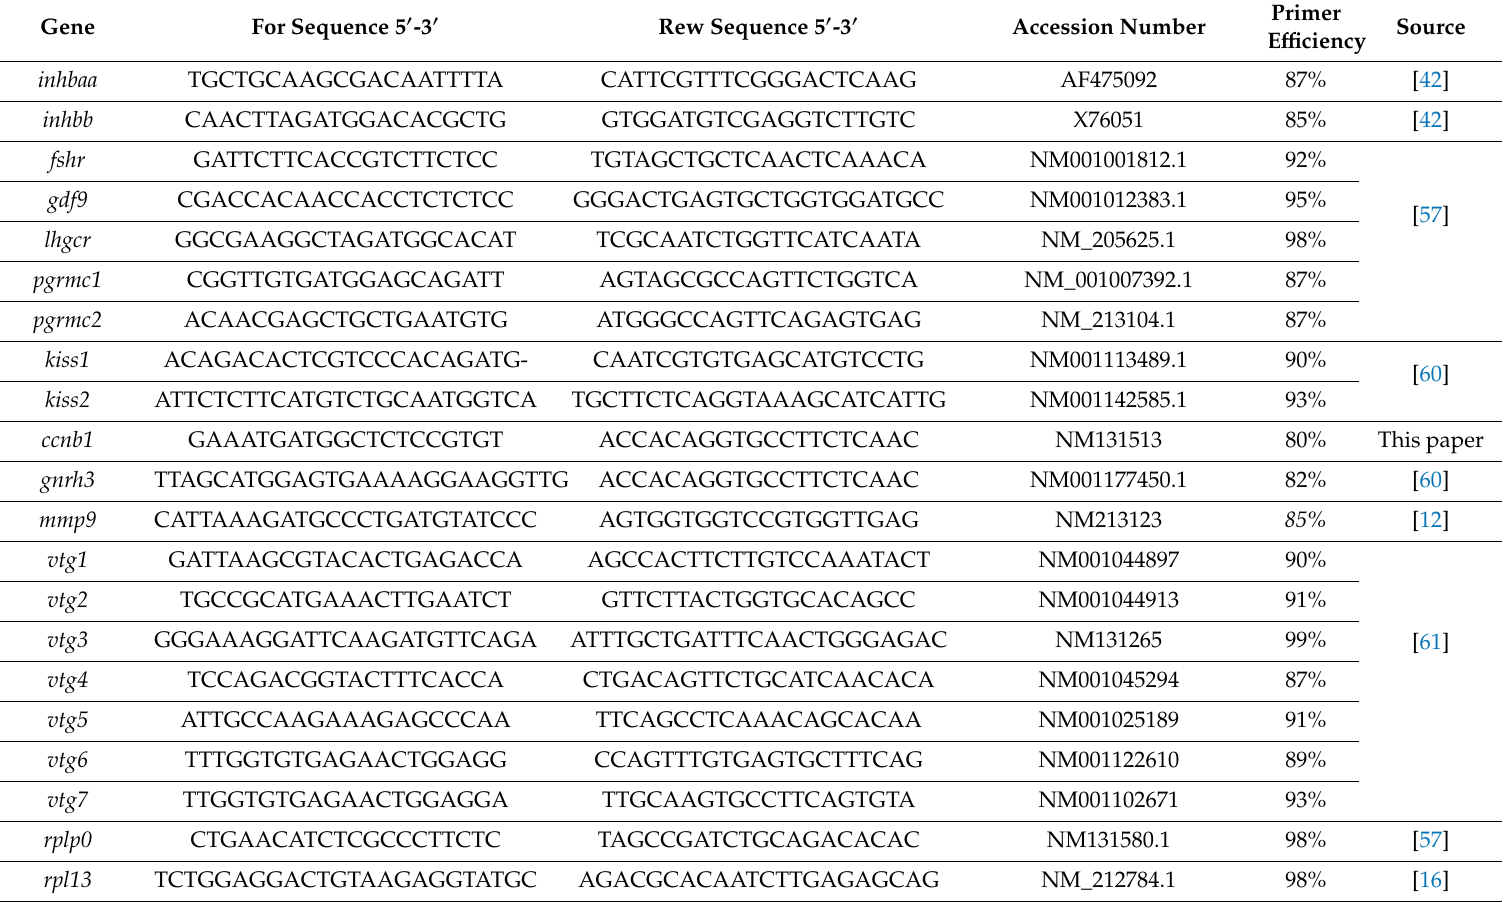
Table 5. Primer sequences, GenBank accession numbers, primer e ffi ciency of the examined genes and